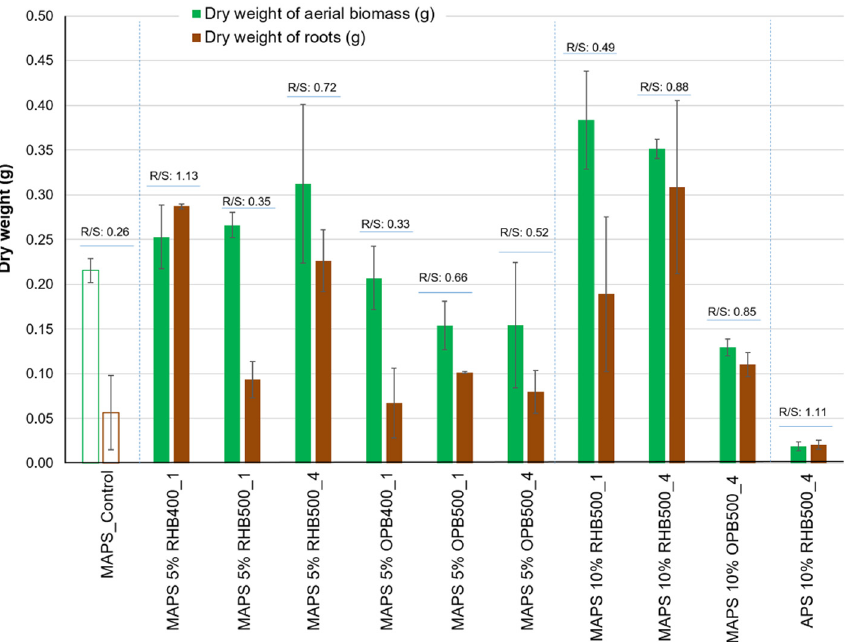
Figure 5. Effects of biochar amendment on dry weight of aerial biomass, dry weight of roots and root-to-shoot ratio at day 65. R/S = Root-to-shoot ratio.